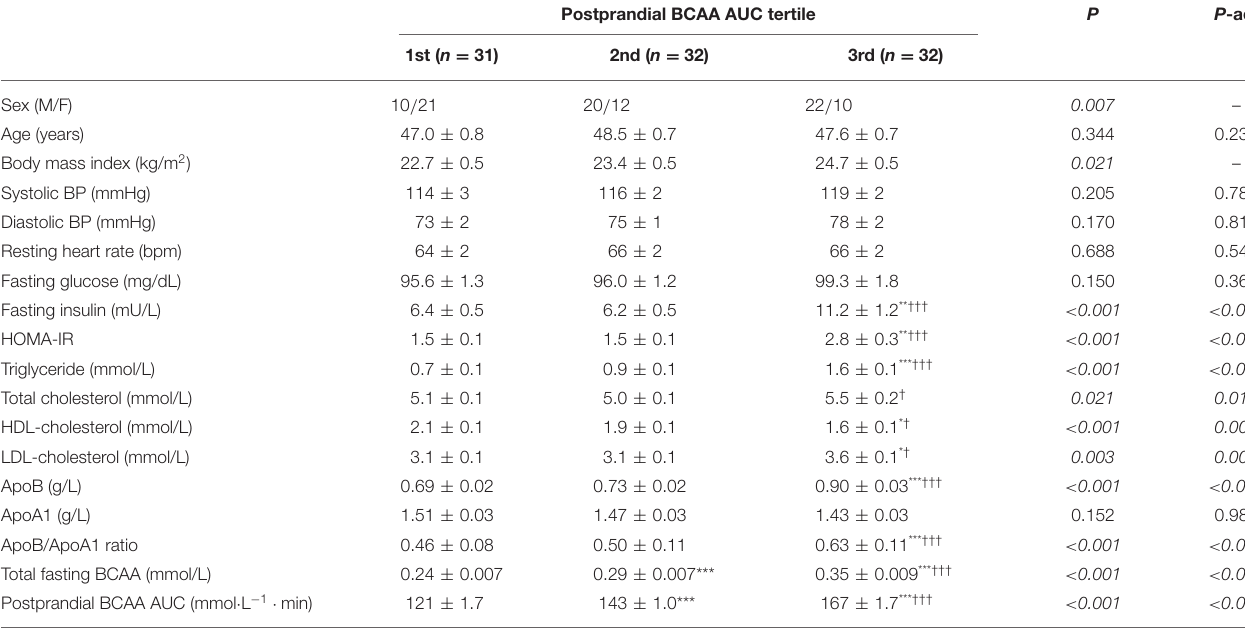
TABLE 2 | Anthropometric characteristics and cardiometabolic parameters of subjects stratified into postprandial BCAA AUC